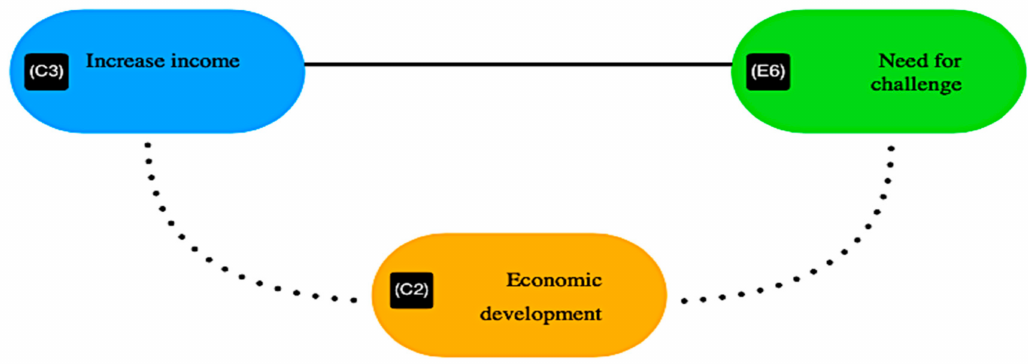
Figure 5. Increasing income and need for challenge: Incidence C 3 → E 6 . Source: Authors’ elaboration based on fuzzy log.